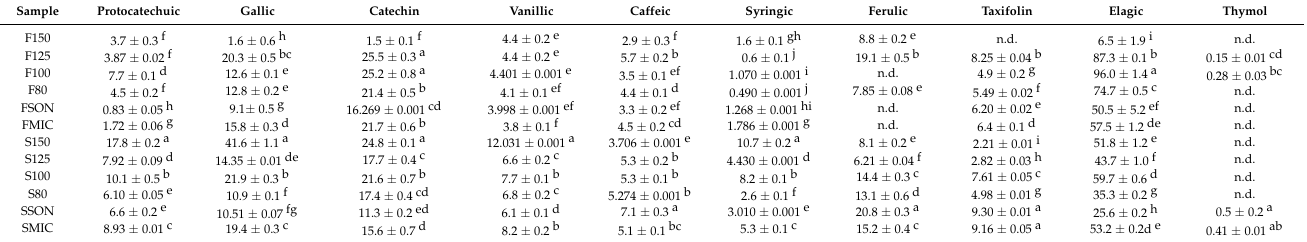
Table 6. Effect of extraction method on phenolic content pecan shell extracts